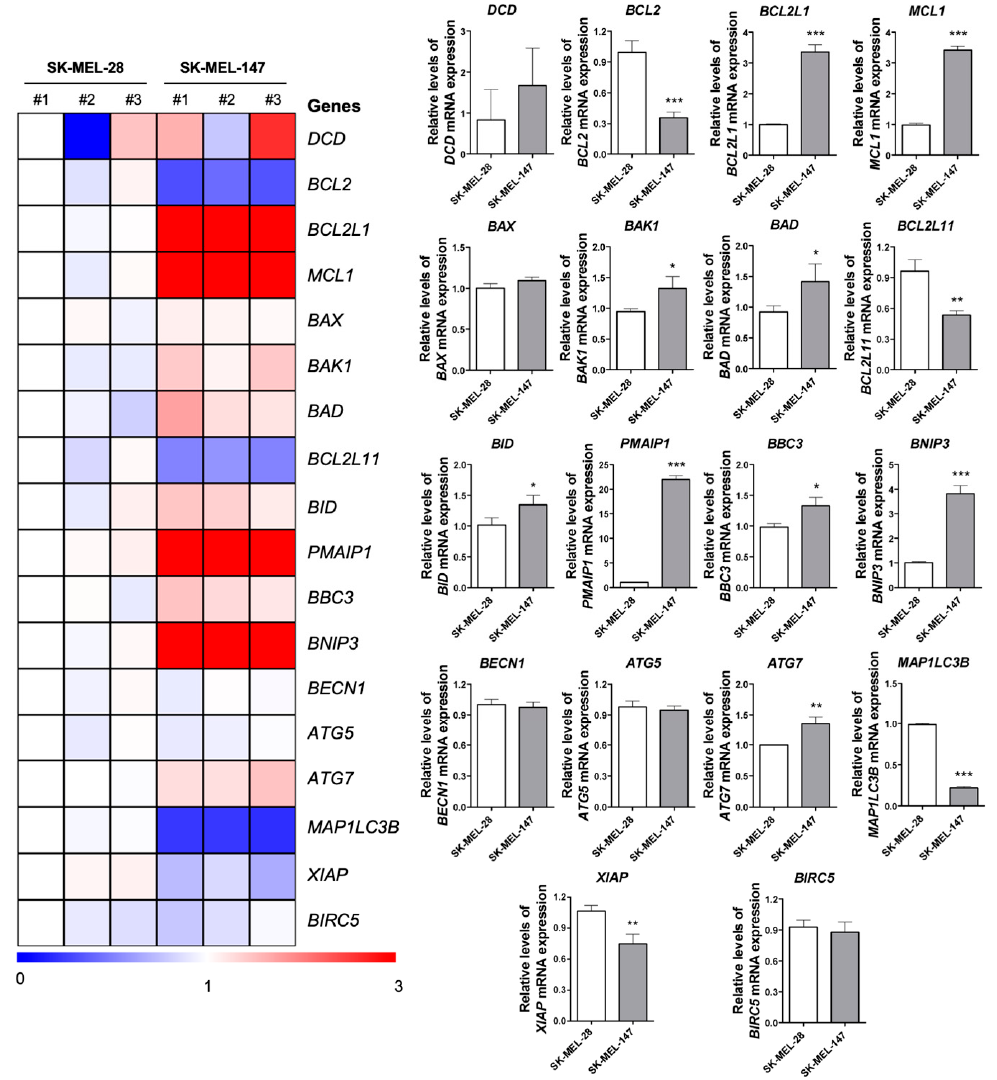
Figure 4. Basal expression of apoptosis and autophagy associated genes in BRAF V600E and NRAS Q61R melanoma cells. A heatmap depicting the levels of select apoptosis- and autophagy-related genes by qPCR analysis in three independent samples from SK-MEL-28 (BRAF V600E ) and SK-MEL-147 (NRAS Q61R ) cell lines. The data are presented as fold change of a sample from SK-MEL-28 cells. Downregulated and upregulated genes are illustrated in blue and red, respectively. Fold-changes of genes expression are presented in bar graphs (mean ± SD). The p values are indicated; * p < 0.05; ** p < 0.01; *** p < 0.001 as determined by a Student’s t -test.